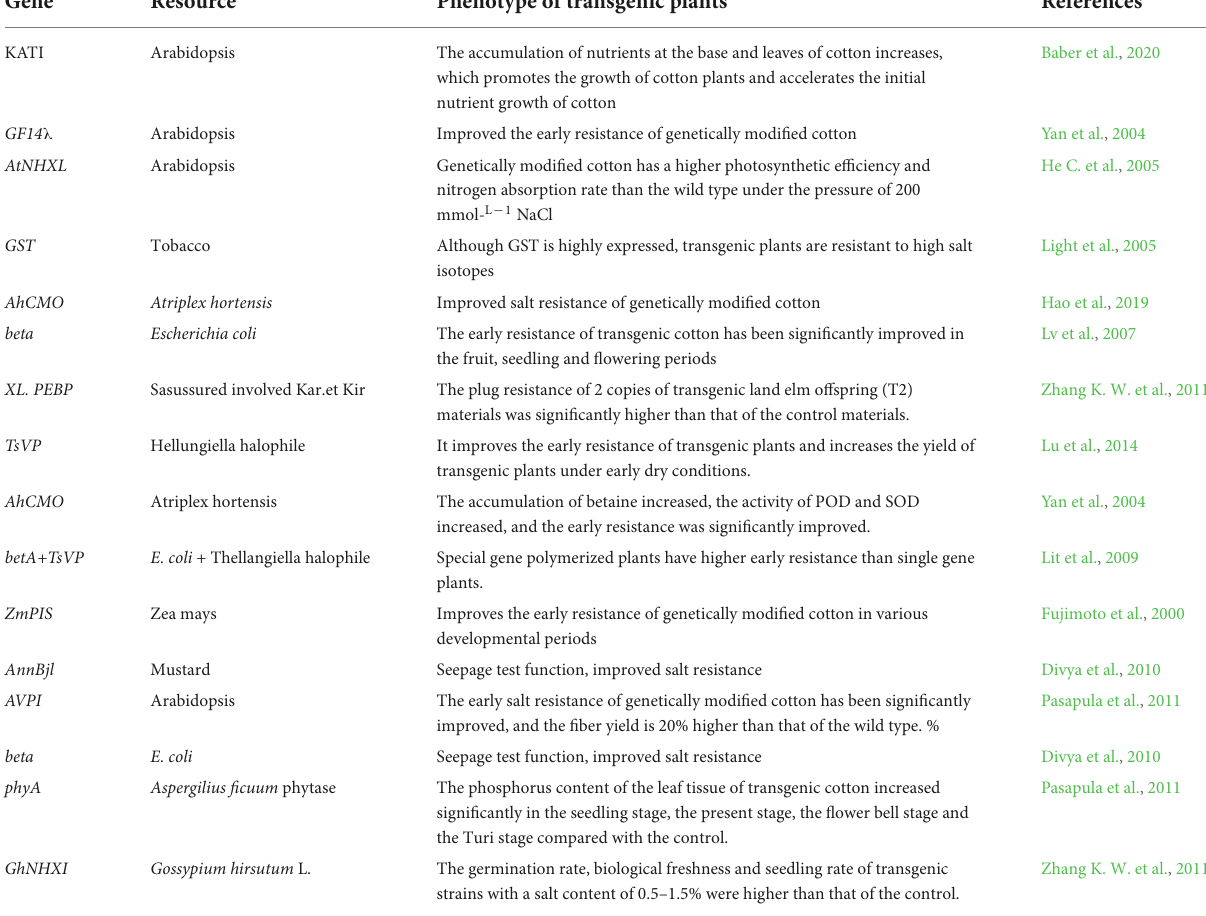
TABLE 2 Transgenic materials associate with stress resistance in